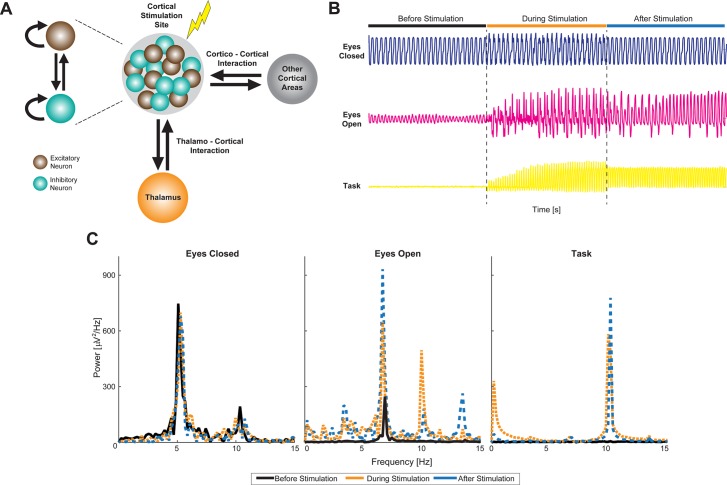
Computational Model Explains Outlasting Effects of Periodic Stimulation.(A) Schematic of computational model that includes the different components and interactions among them. The region of the cortex being stimulated is denoted by a gray circle encompassing excitatory and inhibitory neurons. The model neurons exhibit reciprocal as well as recurrent connections. The cortico-thalamic and cortico-cortical interactions are also modeled to be reciprocal. (B) Membrane potential observed from excitatory neurons in the model shows task-dependent differences in stimulation effect. During the eyes-closed state (blue trace), a strong oscillation is observed in the alpha frequency range. Stimulation onset does not alter the dynamics significantly. In the eyes-open state (magenta trace), an oscillation is still observed in the alpha frequency range. However, the strength is decreased compared to the eyes-closed state. Stimulation onset causes the amplification of this oscillation, which persists after stimulation offset and then slowly decays. In the task-engaged state (yellow trace), no strong oscillation is observed due to the external inputs that model task-related input. In this state, stimulation causes the network to oscillate at the stimulation frequency, which persists and decays in the epoch after stimulation. (C) Spectral analysis of membrane potential reveals state-dependent effect of stimulation. Refer to S1 Fig for dynamics in the absence of cortico-thalamic and cortico-cortical interactions. The data shown in this figure are available online: http://dx.doi.org/10.5281/zenodo.45811